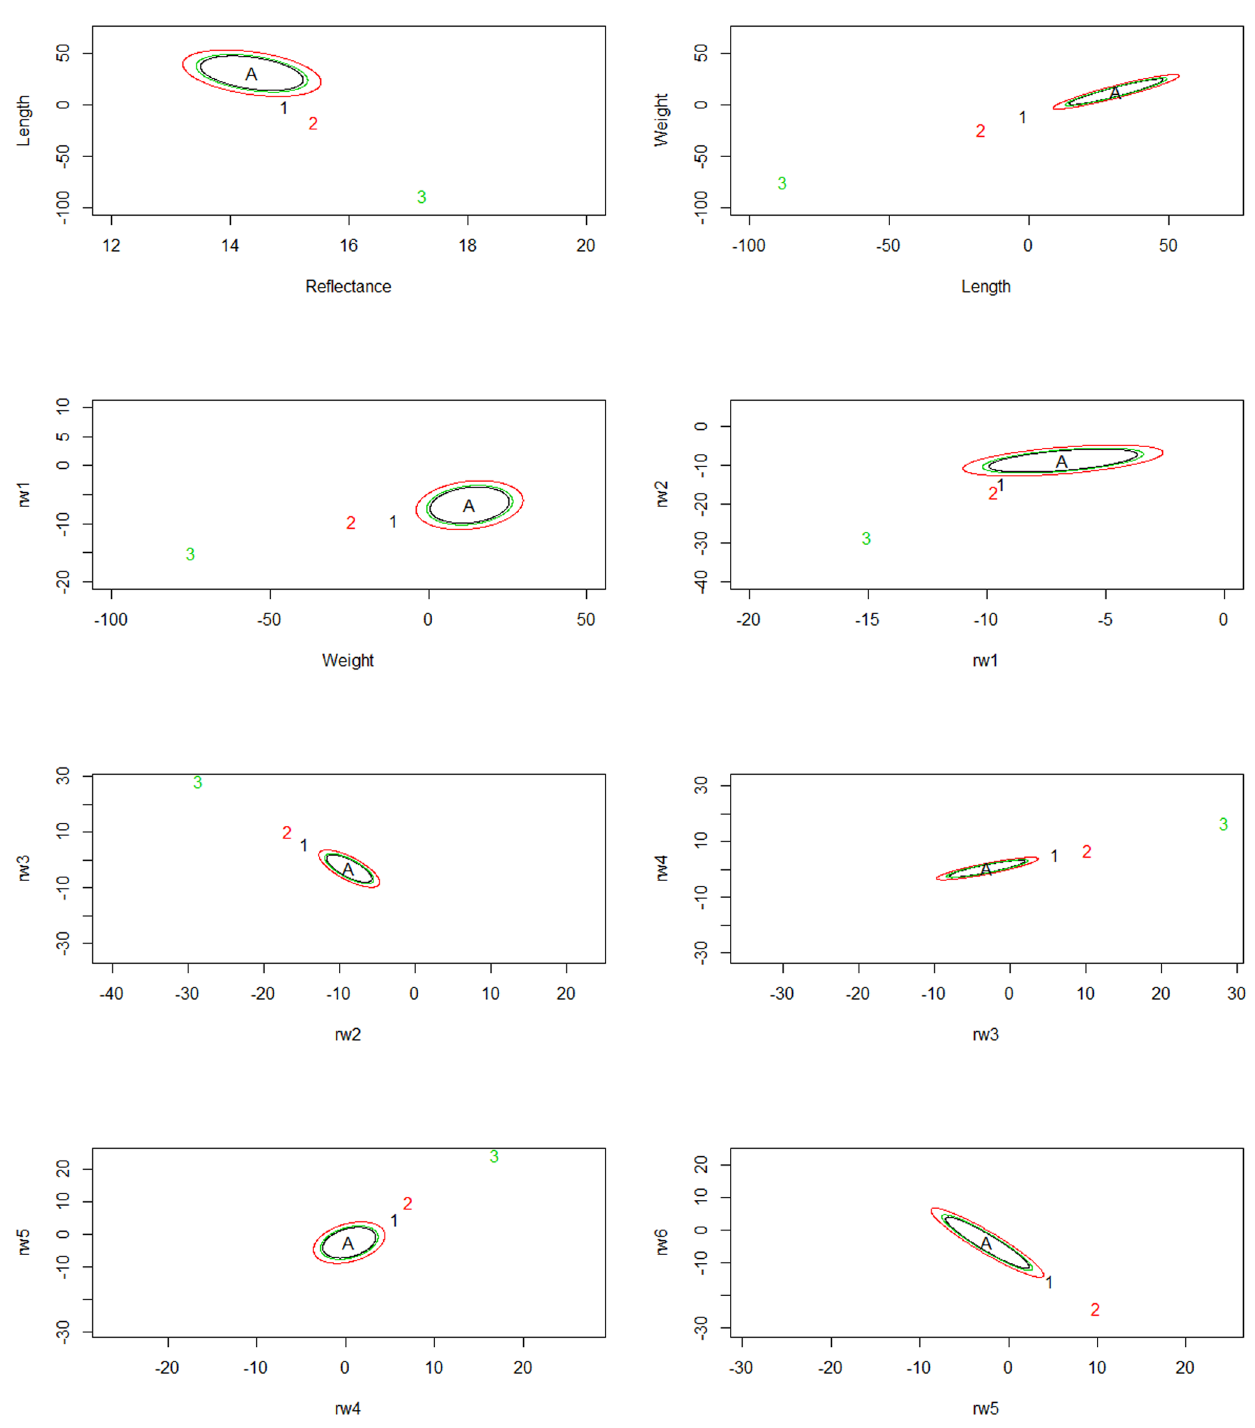
Figure 4. Phenotypic trait distributions for the mean ancestral (A) genotype for trait pairs under neutral expectations at sampling period 2, together with observed population trait values in Assinica (1), Iron River (2), and Siskiwit (3).